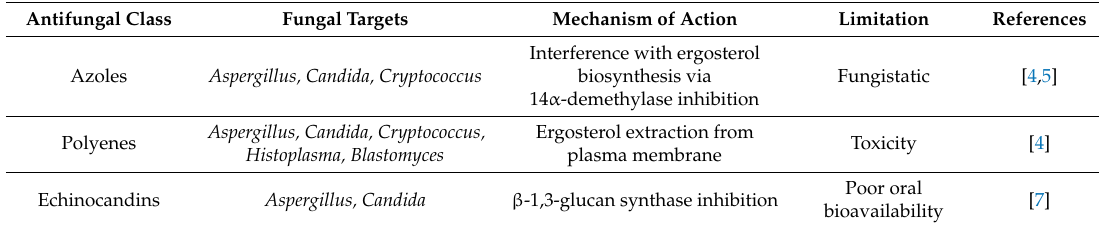
Table 2. Approved antifungals for clinical